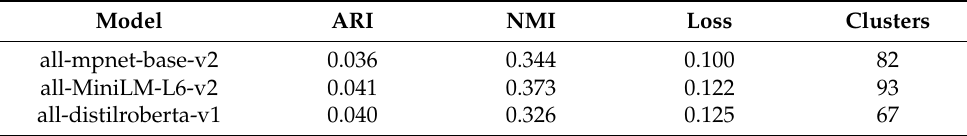
Table 4. Performance of clustering sentence